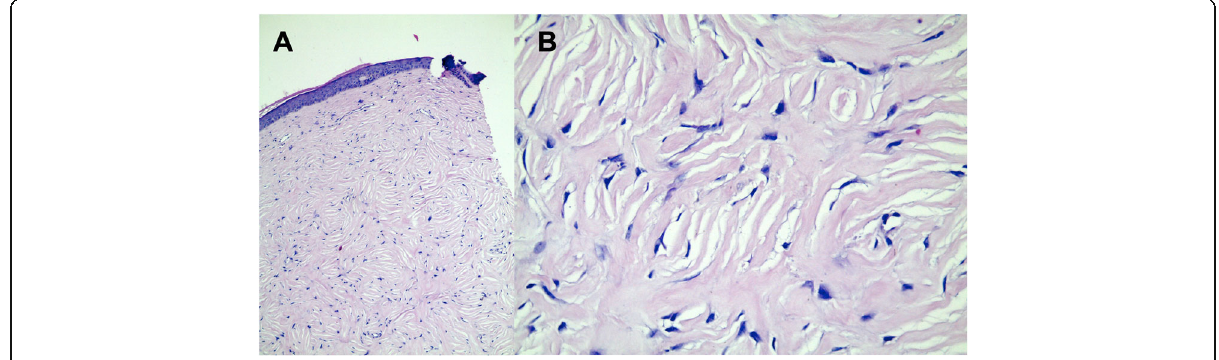
Fig. 1 Fibroepithelial polyp (skin fibroma). a Histological skin sections exhibit a markedly rectified epidermis. In the dermis, mesenchymal cellular proliferation can be observed, consisting of spindle cells with the cytoplasm sometimes indistinct, sometimes spiculated in appearance, containing spindle nuclei without atypia (HE 200x). b The cells are arranged so that “ swirls ” are sometimes formed among the dense collagenized stroma (HE